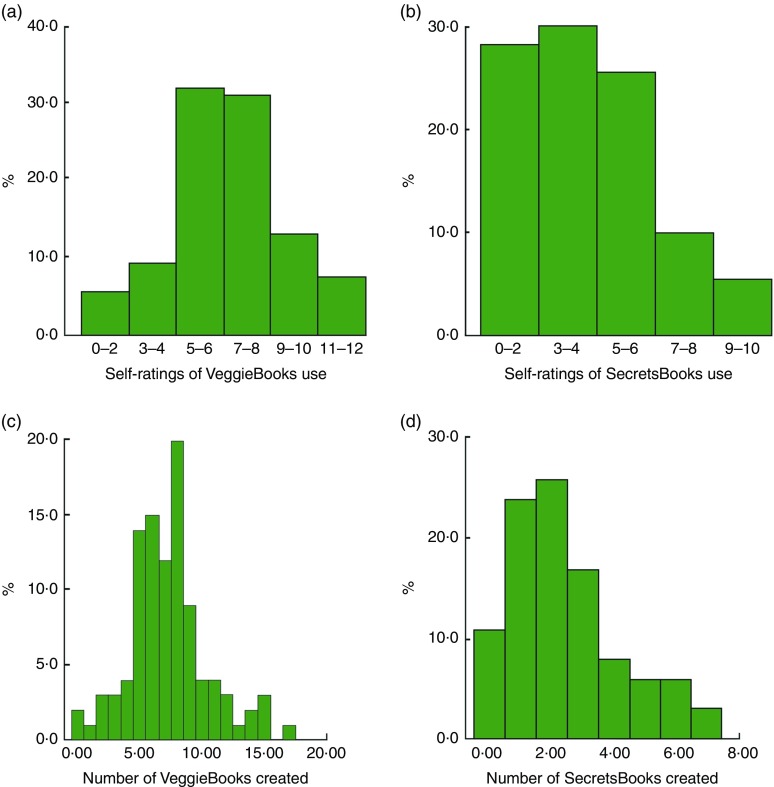
(colour online) Cooks’ use of VeggieBook in the experimental pantries: (a) cooks’ self-ratings of VeggieBooks use, scale values (n 112); (b) cooks’ self-ratings of SecretsBooks use, scale values (n 112); (c) cooks’ number of VeggieBooks created, occasions captured electronically (n 110); and (d) cooks’ number of SecretsBooks created, occasions captured electronically (n 110). Low-income household cooks were clients of fifteen community food pantry distributions in Los Angeles County, USA, and participated in the randomized controlled trial of the VeggieBook mobile phone app with one of their 9–14-year-old children, May 2015–June 2016